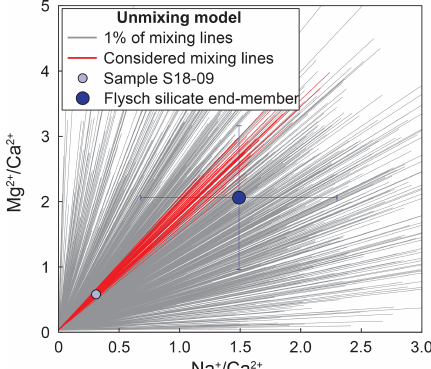
Figure A2. Example of mixing lines from Monte Carlo modeling in Na + / Ca 2 + –Mg 2 + / Ca 2 + space Monte Carlo iterations of the mix- ing model for sample S18-09 (small light-blue point). Flysch sil- icate end-member and 1 σ uncertainty are in dark blue. 1000 out of 100000 (1%) mixing lines from the Monte Carlo modeling are marked as grey lines. Red lines show all runs with χ 2 those 1% of runs.